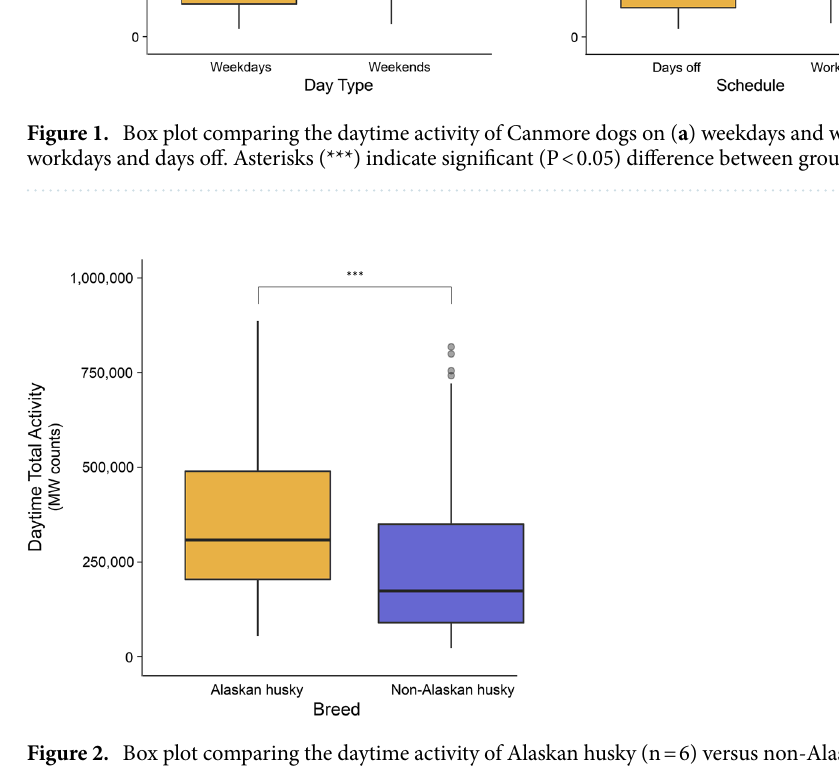
Figure 2. Box plot comparing the daytime activity of Alaskan husky (n = 6) versus non-Alaskan husky (n = 17) dogs from Canmore. Asterisks (***) indicate significant (P < 0.05) difference between